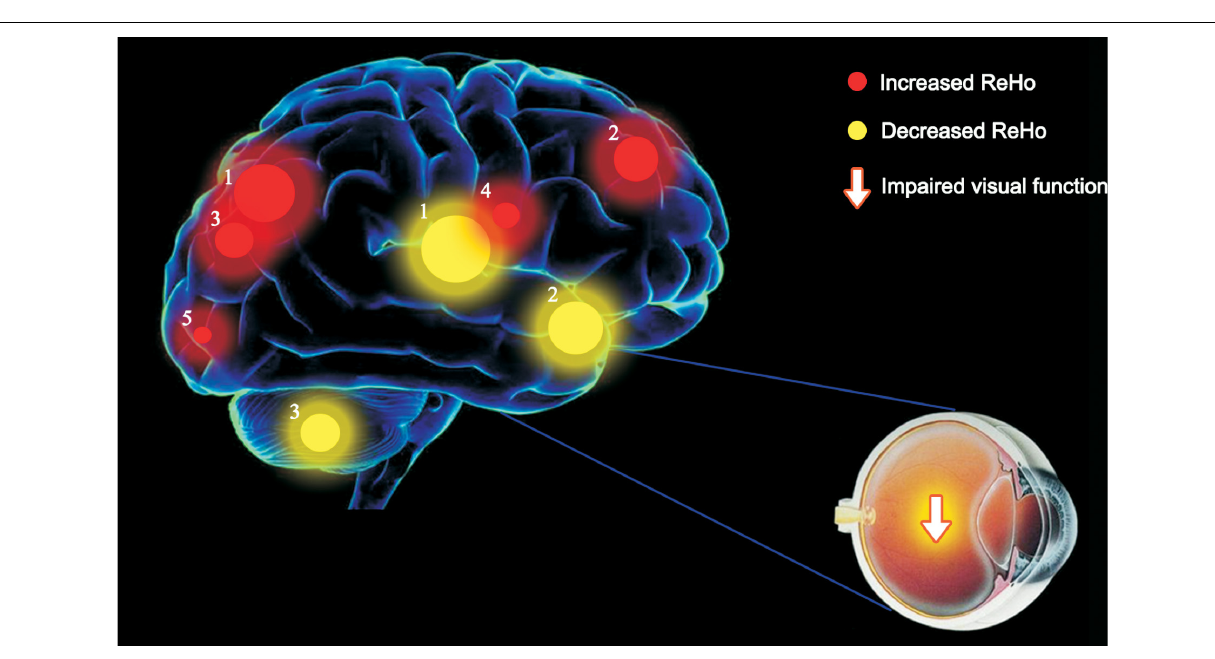
FIGURE 5 | The ReHo values of the altered brain regions. Variable degree of the ReHo values in SA group of the following regions were decreased: 1- Left putamen; ( t = 5.08), 2- Left frontal sup (BA 13, t = 4.95), 3- Right cerebellum ( t = 4.5). The ReHo values of the following brain regions were higher than HCs: 1- Left parietal sup (BA 7, t = –5.47), 2- Right frontal sup medial (BA 8, t = –5.22), 3- Right parietal sup (BA 7, t = –5.05), 4- Right parietal inf (BA 40, t = –4.66), 5- Right lingual (BA 18, t = –4.16). The degree of quantitative change was indicated by the size of spots. ReHo, regional homogeneity; HCs, healthy controls; BA, Brodmann’s